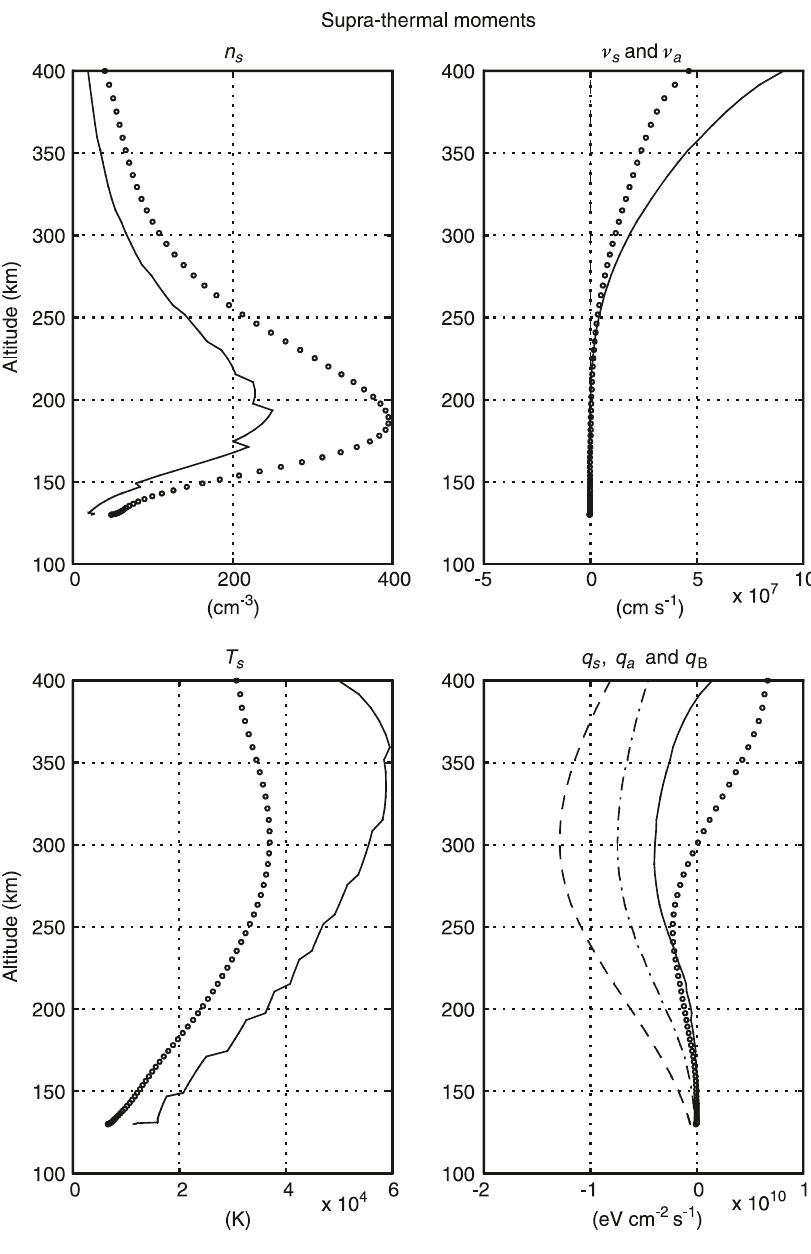
Fig. 11. The parameters of the suprathermal part of the distribution function and the two odd moments of the ambient (Spitzer-Ha¨ rm) distribution. In all four plates, the moments of the raw suprathermal distribution function are represented by circles while the moments of the distribution we use for further calcu- lations are represented by solid lines . In the upper right plate (mean drift velocity), the calculated mean Doppler velocity of the ambient distribution v a is represented by the dash-dot line and as expected is equal to zero (see Eqs. 11–13). On the lower right plate (heat flow), the calculated heat flow of the ambient distribution q a is represented by the dash-dot line and the dashed line corresponds to the heat flow q B given by